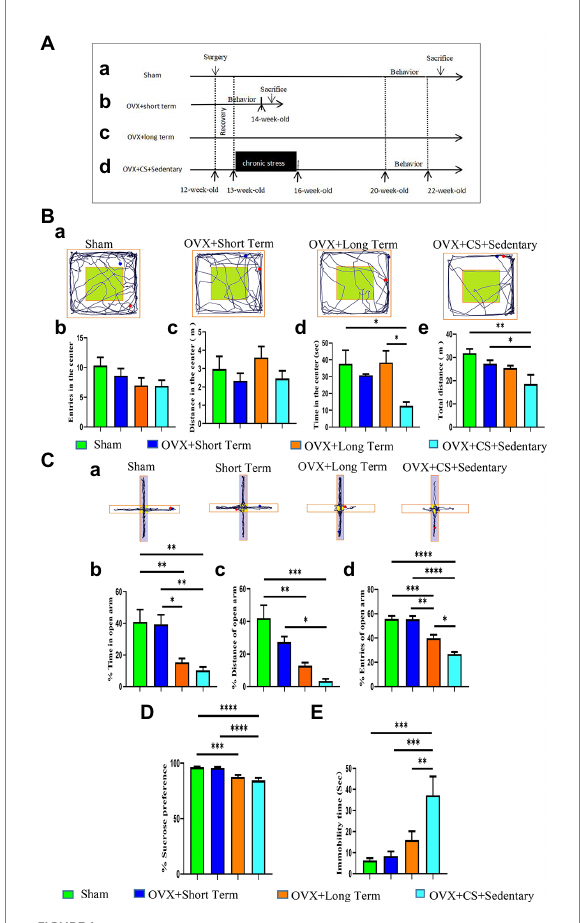
FIGURE 1 Experimental design (A) and ovariectomy accelerates the development of chronic stress-induced anxiety-depression-like behaviors (B , C) . (A) After 4 weeks of adaptive rearing, Sham surgery and bilateral ovariectomy (OVX) were performed on all 13-week- old female SD rats. Chronic restraint stress (CS, 7.5–8 h/day, 0:00- 7:30/8:00, for 21 days). Pharmacological or exercise interventions were performed after completion of the stress protocol. behavioral tests (OFT, EPM, SPT, 3-chamber, BM, FST) of rats in Sham group, OVX+Long term group and OVX+CS+Sedentary group were performed during 21–22 weeks of age. Behavioral tests of rats in the OVX+Short term group were performed at 14 weeks of age. (B) Representative movement trajectory plots of rats in each group in the open field test (a) . The number of times rats entered the central area (b) , the time spent moving in the central area (c) , the distance moved in the central area (d) , and the total distance moved in the open field area (e) in the open field test. (C) Representative activity trajectories of rats in the elevated cross maze for each group (a) . The percentage of time rats spent moving on the open arm (white area) (b) , the percentage of distance moved on the open arm (c) , and the percentage of times they entered the open arm area (d) . (D) Percentage of sugar water preference in the sugar water preference test, sugar water intake as a percentage of total fluid intake. (E) Duration of immobility in the forced swim test. The cumulative time of immobility was analyzed. All values are expressed as mean ± SEM. * P < 0.05, ** P < 0.01, *** P < 0.001, **** P <